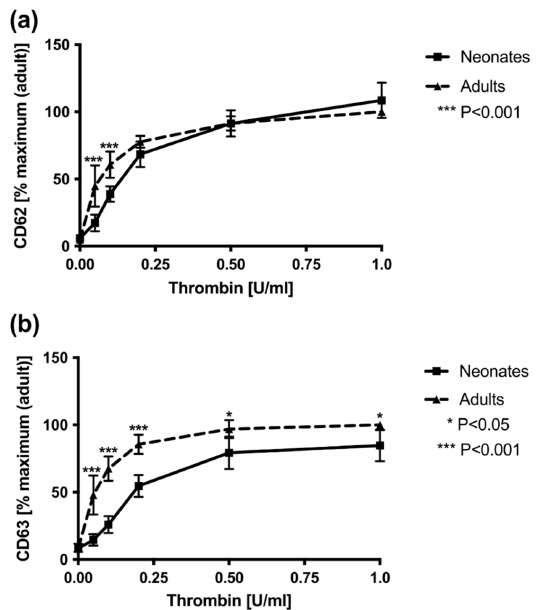
Figure 1. Surface expression of CD62 ( a ) andCD63 ( b ) in diluted platelet-rich plasma obtained from adult and neonatal samples ex vivo and after stimulation with increasing concentrations of thrombin. Results are presented as mean ± SD. Data ( n = 11 per cohort) are normalized to maximal re- sponse measured in adult control samples run in parallel. *** p < 0.001; * p < 0.05.